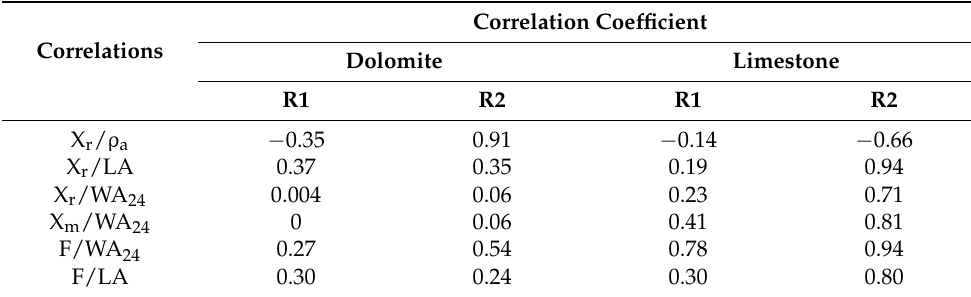
Table 3. Correlation coefficient for different relationships: R1—data before averaging, linear function; R2—data after averaging, best-fit function.